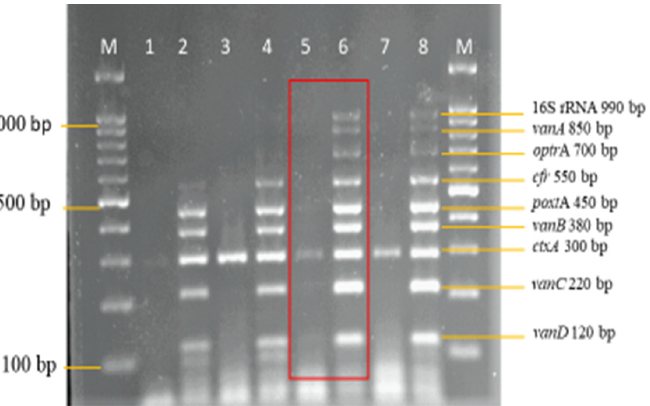
Figure 8. Internal amplification control template concentration optimization in the multiplex PCR Assay. A concentration of 10 pg/ μ L on lanes 5 and 6 from a range of template concentrations (1 ng/ μ L–1 pg/ μ L) was selected as the optimum template concentration. Lane M: DNA ladder 100 bp